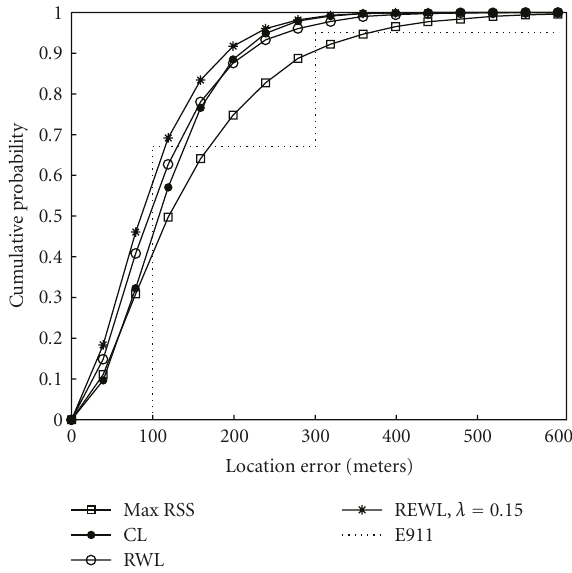
Figure 9: Algorithm location error CDF for four receivers at